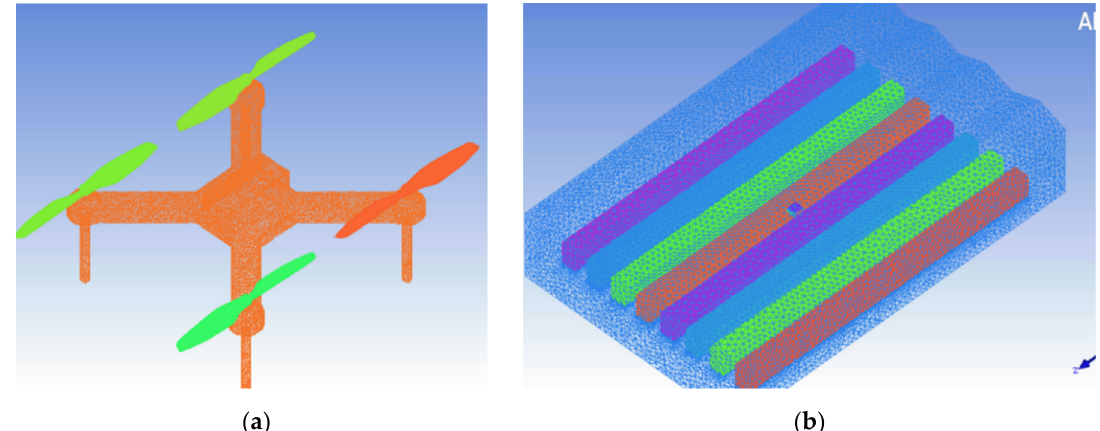
Figure 4. Mesh model; ( a ) UAV; ( b ) Greenhouse.